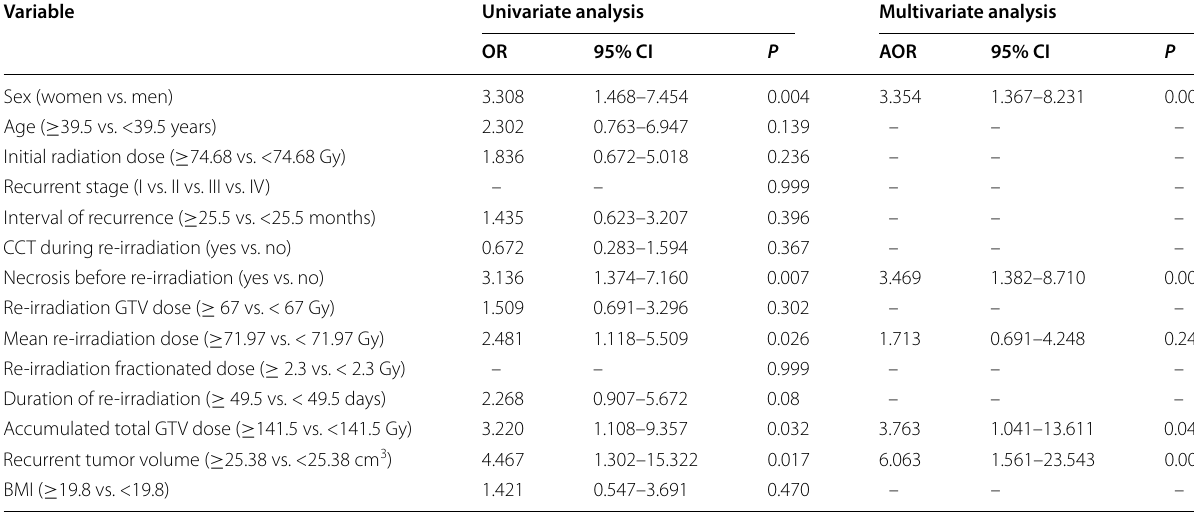
LNN lethal nasopharyngeal necrosis, CI , confidence interval, CCT concurrent chemoradiotherapy, GTV gross tumor volume, BMI body mass index, OR odds ratio, AOR adjusted odds ratio